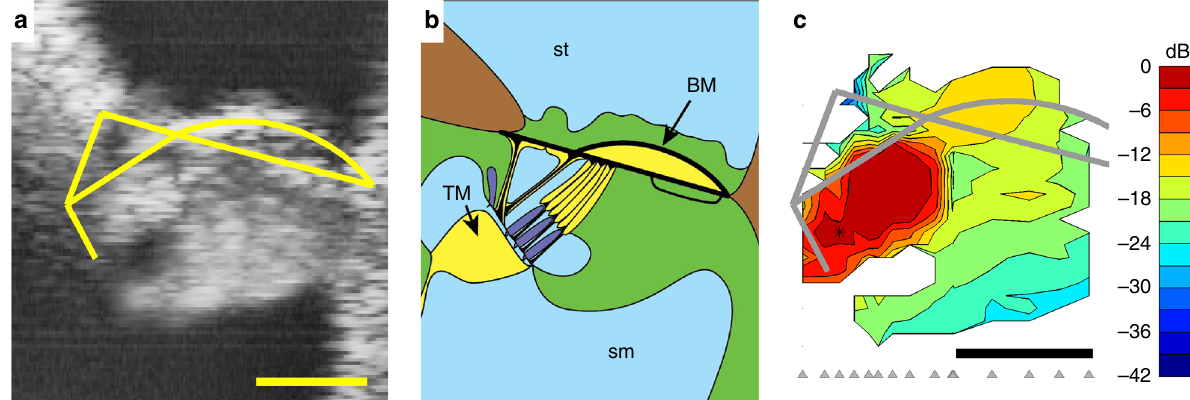
Fig. 2 A vibration hotspot at low sound levels in the organ of Corti. a OCT re fl ectance image (grayscale), with structural framework of Corti ’ s organ (yellow) superimposed for reference. Scale bar (bottom), 0.05 mm. b Underlying anatomical structures, labeled as in Fig. 1c. c Map of vibration magnitudes evoked by the 22.6 kHz component of a multi-tone stimulus at 40 dB SPL. Magnitudes are expressed in decibels relative to the 3-nm maximum observed at the location marked with an asterisk. Measurement beam ordinates are indicated at the base of the map using gray arrowheads, and the axial (vertical, z ) resolution is ~8 µ m. Vibrations clearly focus on a hotspot that encompasses the OHC and Deiters ’ cell bodies, and sits well within the boundaries of the organ of Corti ’ s structure (gray framework). Scale bar, 0.05 mm. Preparation RG16725, CF 23